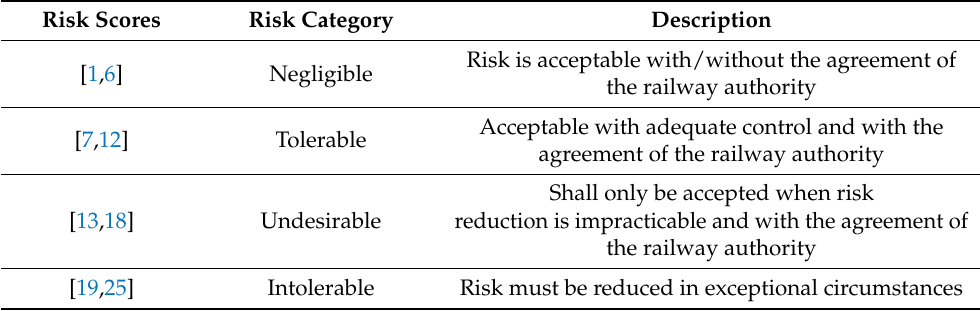
Table 7. Risk acceptance criteria of the train operation